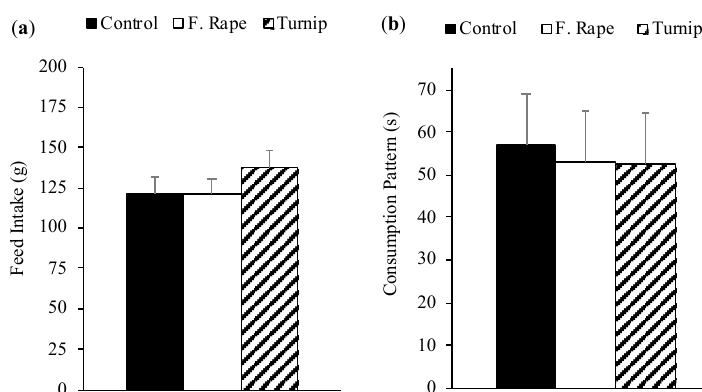
Figure 1. Pigs’ feed intake ( a ) and palatability ( b ) expressed as consumption patterns (consumption time / number of approaches to the feeder) of corn–soybean base diets (least squares means + standard error) with the inclusion of 15% of forage rape, turnip, or wheat middlings (control) when animals were offered one consumption option for 10 min. Table 2. Consumption pattern (consumption time / number of approaches to the feeder) over 10 min from growing pigs ( n = 4) exposed to corn–soybean base diets with the inclusion of 15% of forage rape, turnip, or wheat middling as the control diet expressed by the first (0–5 min), last (6–10 min), and total (0–10 min) periods of the test.